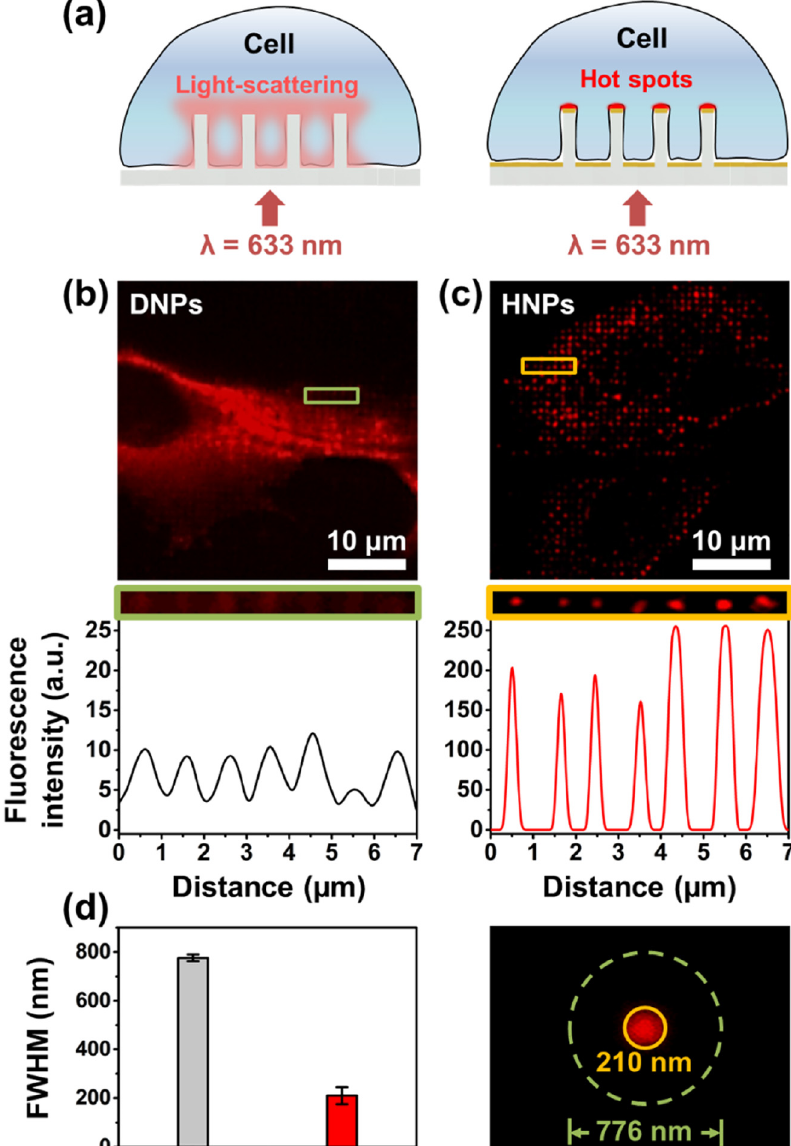
Figure 3: Measurement of fluorescence emissioncoupledwith evanescentfieldson DNPsandplasmonhot-spotsonHNPsusing one-photon fluorescence microscopy. (a) Schematic illumination of optical fields obtained by photonic waveguides on DNPs (left) and by plasmon focusing at the gold caps of HNPs (right). (b) Fluorescence images of HeLa cells cultured on and collected fluorescence intensity profile of zoomed-in fluorescent spot arrays with labelled cells. (c) HNP-concentrated fluorescence images, which exploit pixelated fluorescent point arrays at the plasmonic caps of HNPs that achieve emission spectra with high signal-to- background ratio and enhanced signal intensity. (d) Fluorescence FWHM comparison of individual fluorescent spots illuminated by DNPs and